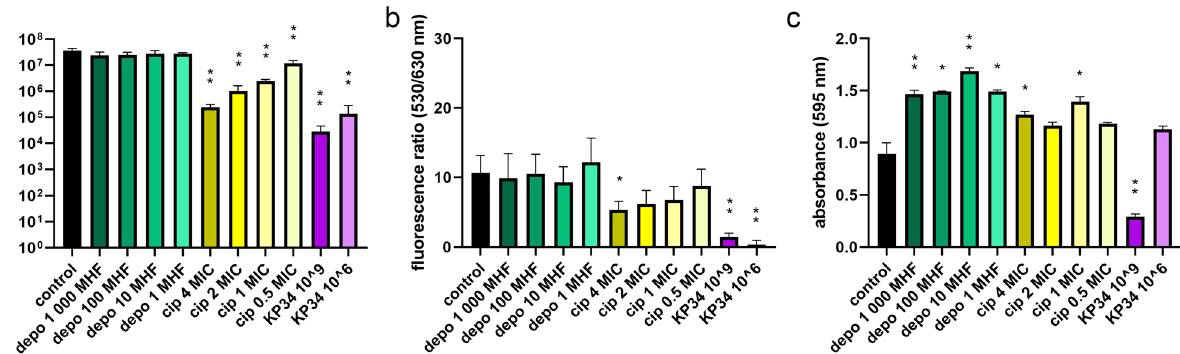
Figure 3. The influence of depolymerase, ciprofloxacin, and infective phage KP34 on K. pneumoniae 77 biofilm formed for 72 h on polystyrene pegs. Three - day biofilm was treated for 2 h with: recombinant depolymerase KP34p57 originated from phage KP34 marked as depo, at concentrations corresponding to 1000 MHF (minimal halo forming concentration), 100 MHF, 10 MHF, and 1 MHF, green bars; ciprofloxacin marked as cip, at concentrations corresponding to 4 MIC (minimal inhibitory concentration), 2 MIC, 1 MIC, and 0.5 MIC, yellow bars; and lytic phage KP34 marked as KP34 (10 9 PFU/ml and 10 6 PFU/ml, violet bars). Biofilm eradication was examined with three different microtiter methods: ( a ) the colony count (CFU/ml); ( b ) LIVE/DEAD BacLight Bacterial Viability Kit with live to dead cells ratio at fluorescence 530/630 nm; ( c ) the crystal violet staining and the level of absorbance at 595 nm. P -value < 0.001 (indicated as two asterisks) and P- value between 0.01 and 0.001 (indicated as one asterisk) were considered statistically